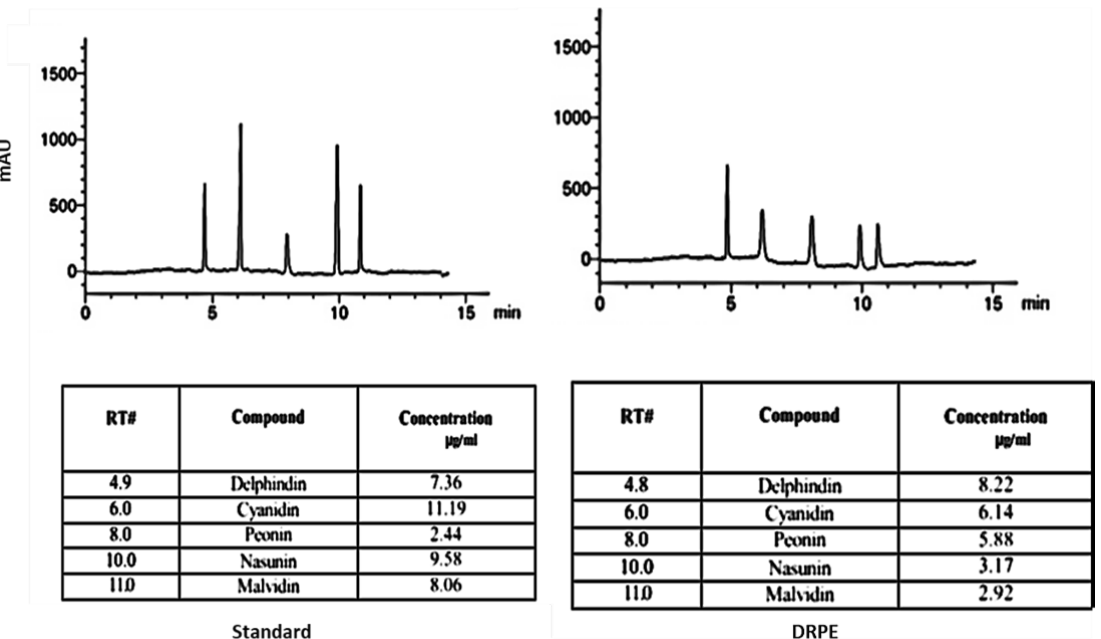
Figure 3. Anthocyanin’s profile detected by HPLC at 520 nm.